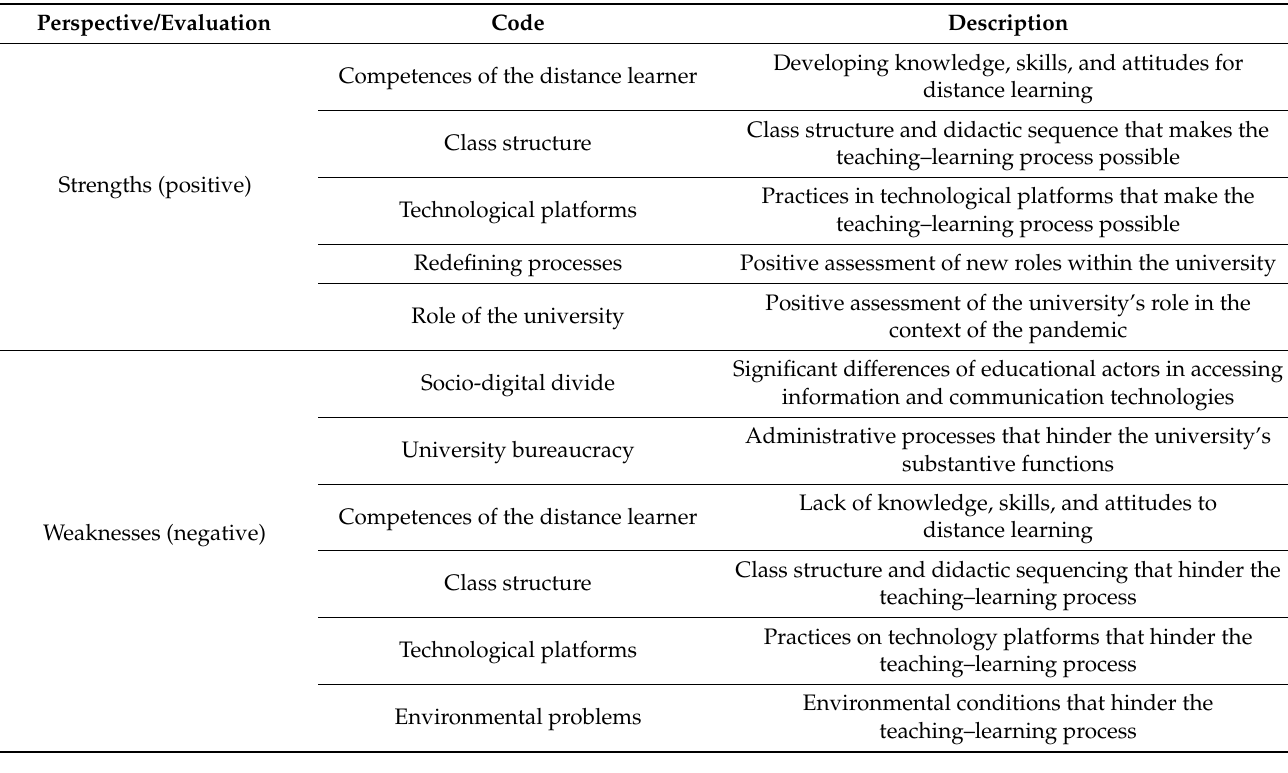
Table 3. Codes in the material–economic agreement.